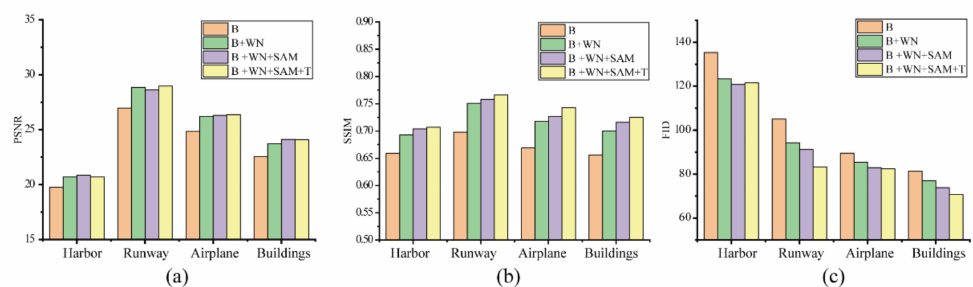
Figure 8. AblationresultsofPSNR( a ) ↑ , SSIM( b ) ↑ , andFID( c ) ↓ valuesusingtheUCMercedLandUse dataset. Baseline, ESRGAN; Baseline + WN, baseline combined with the WN layer; Baseline + WN + SAM, baseline combined with the WN and SAM modules; Baseline + WN + SAM + Texture, final combination of the SAM module, WN layer, and texture loss